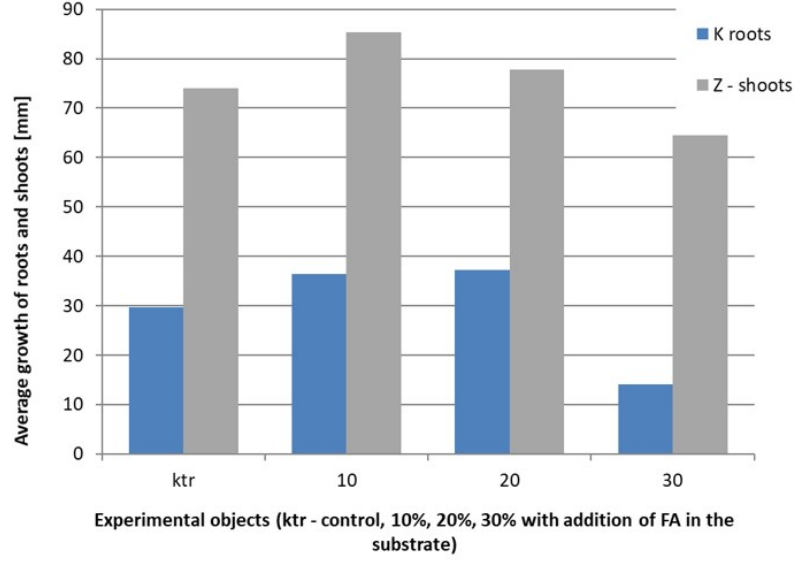
Figure 4. The growth of roots (K) and shoots (Z) of Lepidium sativum on the medium with different FA ash content.